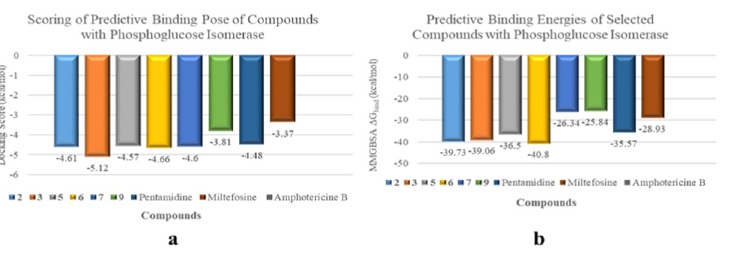
Fig 8. Docking scores of selected compounds (2, 3, 5, 6, 7, and 9) against leishmanial phosphoglucose isomerase (carbohydrate metabolism).